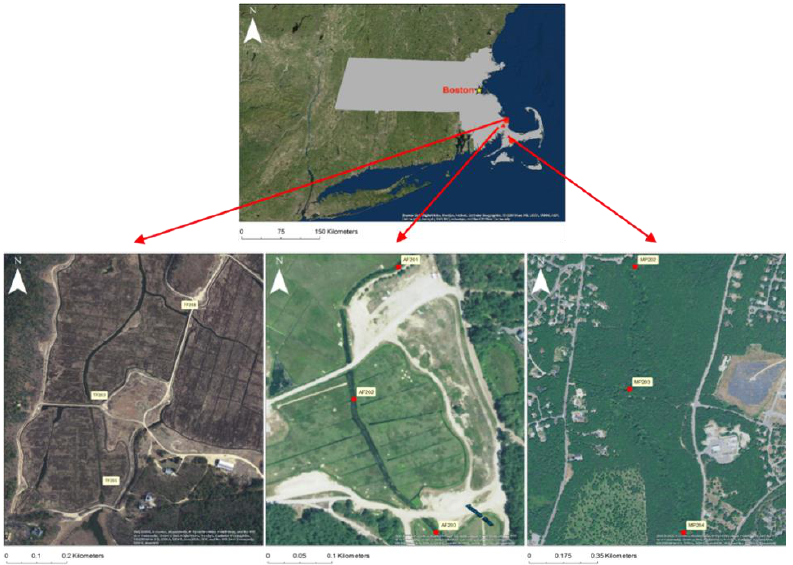
Figure 1. Experimental treatment study locations and their relative locations in Southeastern Mas- sachusetts. From left to right: Tidmarsh Farms (CBR, pre-restoration imagery), an active flow-through cranberry bog (ACB), and the Mashpee River flowing through the Trustees of Reservations conservation land (LIR) Maps produced with ArcGIS 10.4 [19].